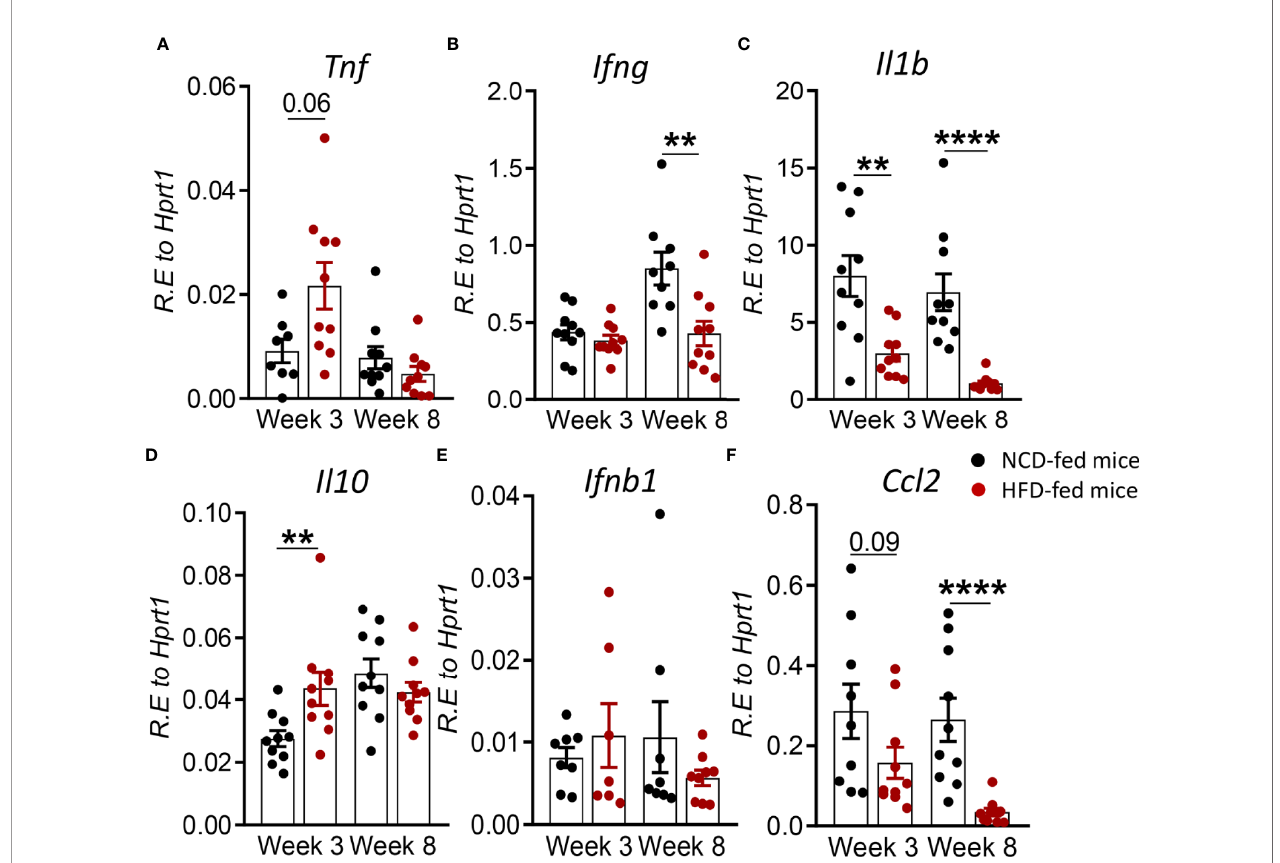
FIGURE 4 | Pre-diabetes alters cytokine responses to Mtb in the periphery. Cytokine mRNA expression was determined by qRT - PCR in blood from NCD- and HFD-fed mice at 3- and 8-weeks p.i. (A) Tnf , (B) Ifng , (C) Il1b , (D) Il10 , ( E ) Ifnb1 , and (F) Ccl2 . Data are means ± SEM (n=7-10 mice/group analyzed in one independent experiment). Data analysis was performed by Mann-Whitney U test. ns = not signi fi cant **p < 0.01, and ****p <